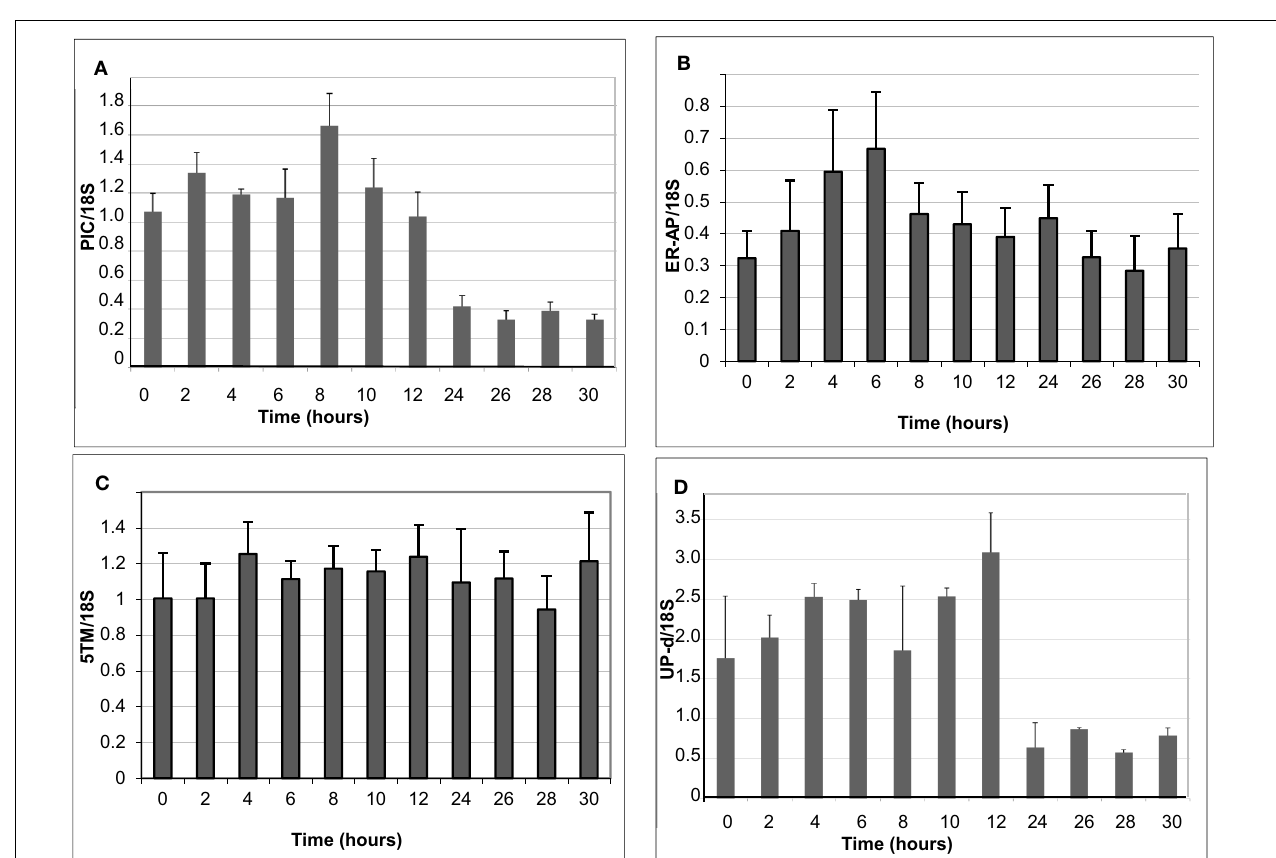
FIGURE 6 | Change in the expression of genes encoding the PIC-like protein (A), ER-AP (B), 5TM protein (C), and UP-d (D). Values were obtained from five to six biological replicates.